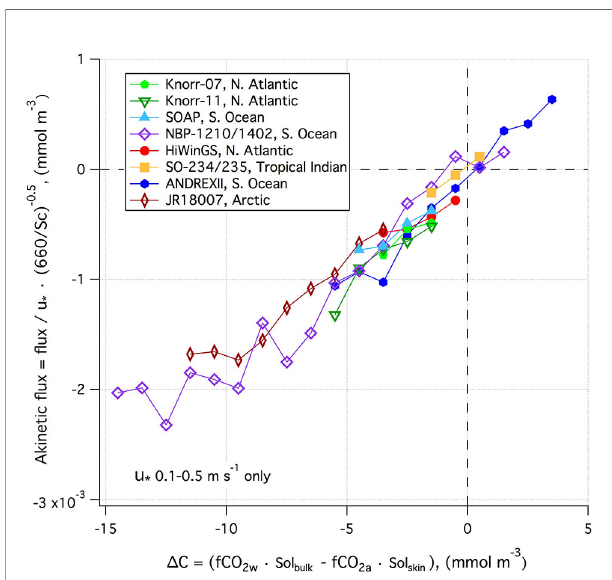
FIGURE 3 | Akinetic fl ux vs. the air-sea concentration difference in moderate